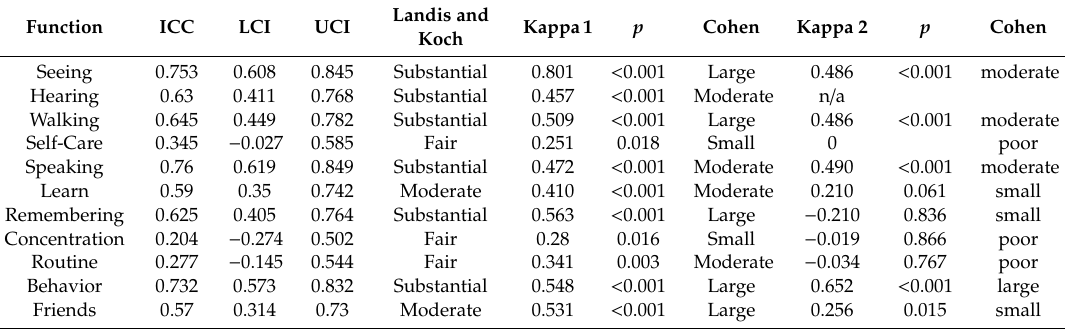
Table 4. Intra-rater reliability results of self-reported child functioning